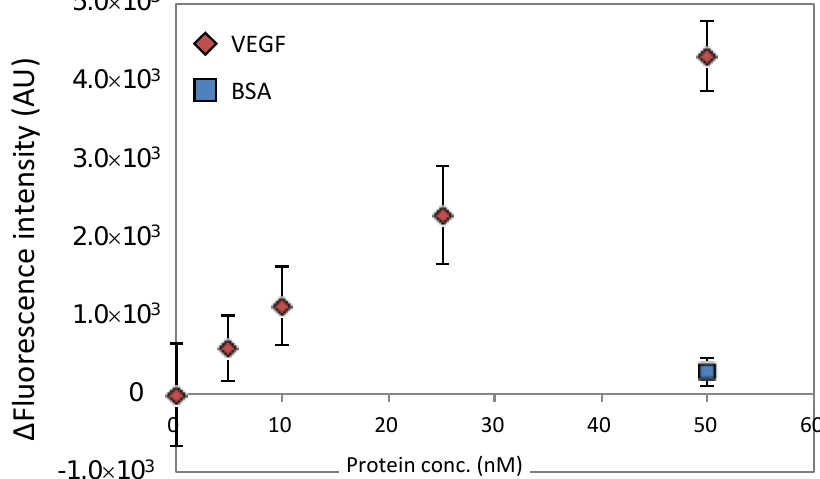
Figure 3. Calibration graph for VEGF using aptamer-based B/F separation with CaPNA4. The fluorescein-labeled VEGF aptamer (10 nM) and CaPNA4-immobilized beads (10 μ L) were used. The fluorescence intensity of the supernatant was measured (mean  SD; n = 3). The red diamonds show the fluorescence intensity in the presence of each concentration of VEGF. The blue diamond shows the fluorescence intensity in the presence of BSA (50